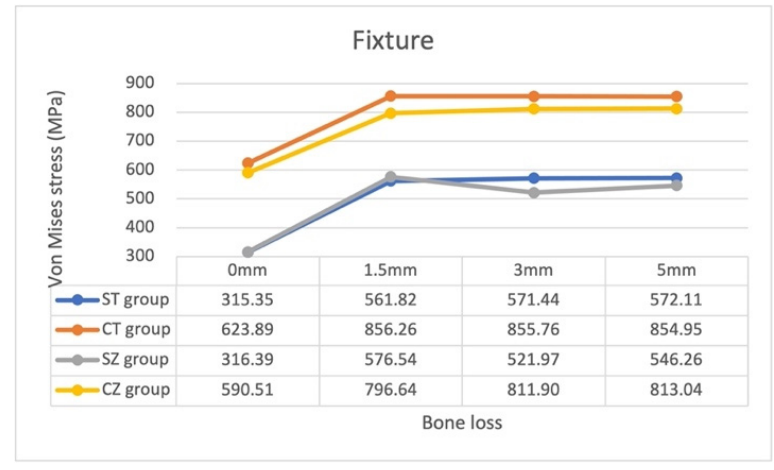
Figure 6. Maximum von Mises stress on the fixture in the 16 models.